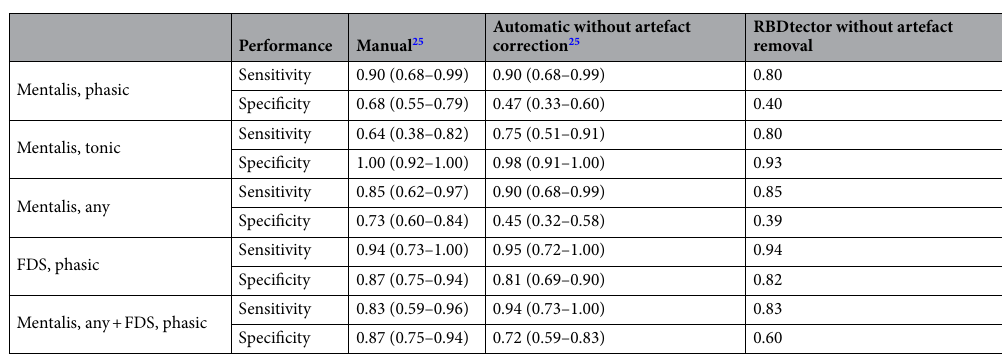
Table 6. Comparison of performance detection for RBD achieved in a previously published dataset 25 . The data obtained from the publication of Frauscher et al. 25 are shown as mean and 95% confidence